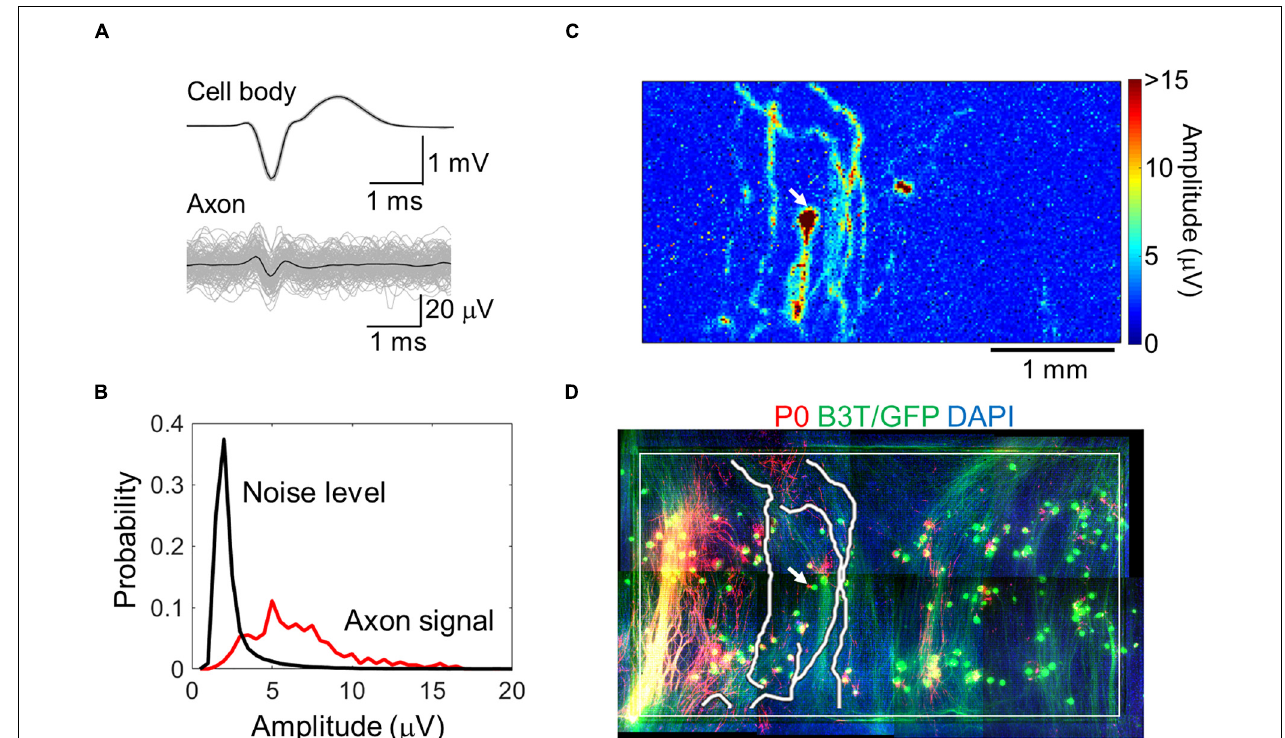
FIGURE 2 | Axon signal detection with a high-density microelectrode array. Averaged cell body and axon signals (black) with individual signals (light gray) (A) . Comparison between the axon signal and noise level (B) . Spike amplitude map for a representative neuron calculated with the spike triggered averaging method (C) . Detected axon segments and immunofluorescent image of the neuron (D) . Red, green, and blue colors show P0 protein (myelin sheath), green fluorescent protein and beta III tubulin (neuron), and DAPI (cell nuclei), respectively. The white rectangle shows the recording area. Image for the whole recording area was made by combining multiple images. Electrical recording at 58 DIV, immunofluorescent imaging at 77 DIV.